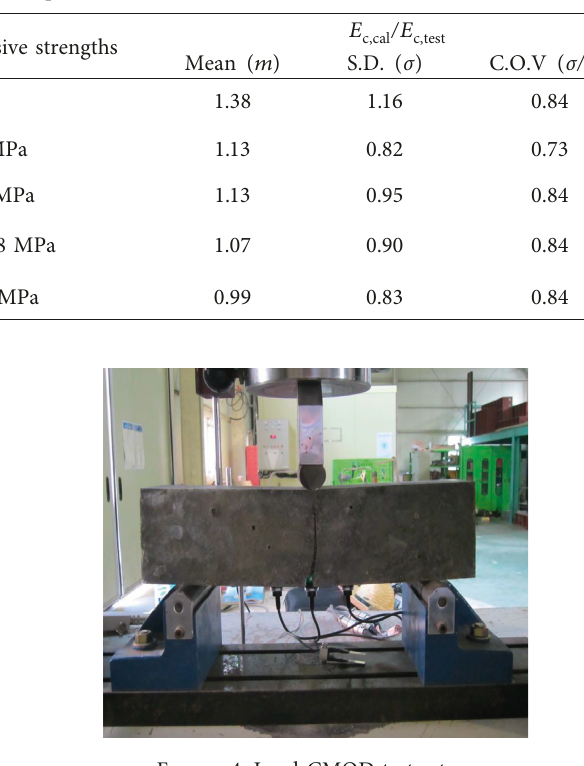
Figure 4: Load-CMOD test setup.